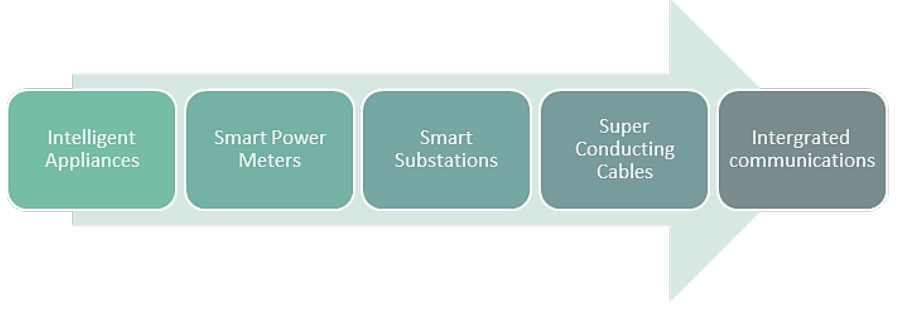
Figure 3. The smart grid system SGS modules.